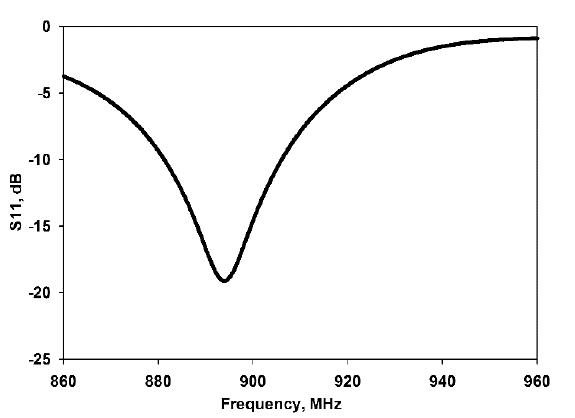
Figure 3: variation of return loss with frequency for the proposed tag antenna